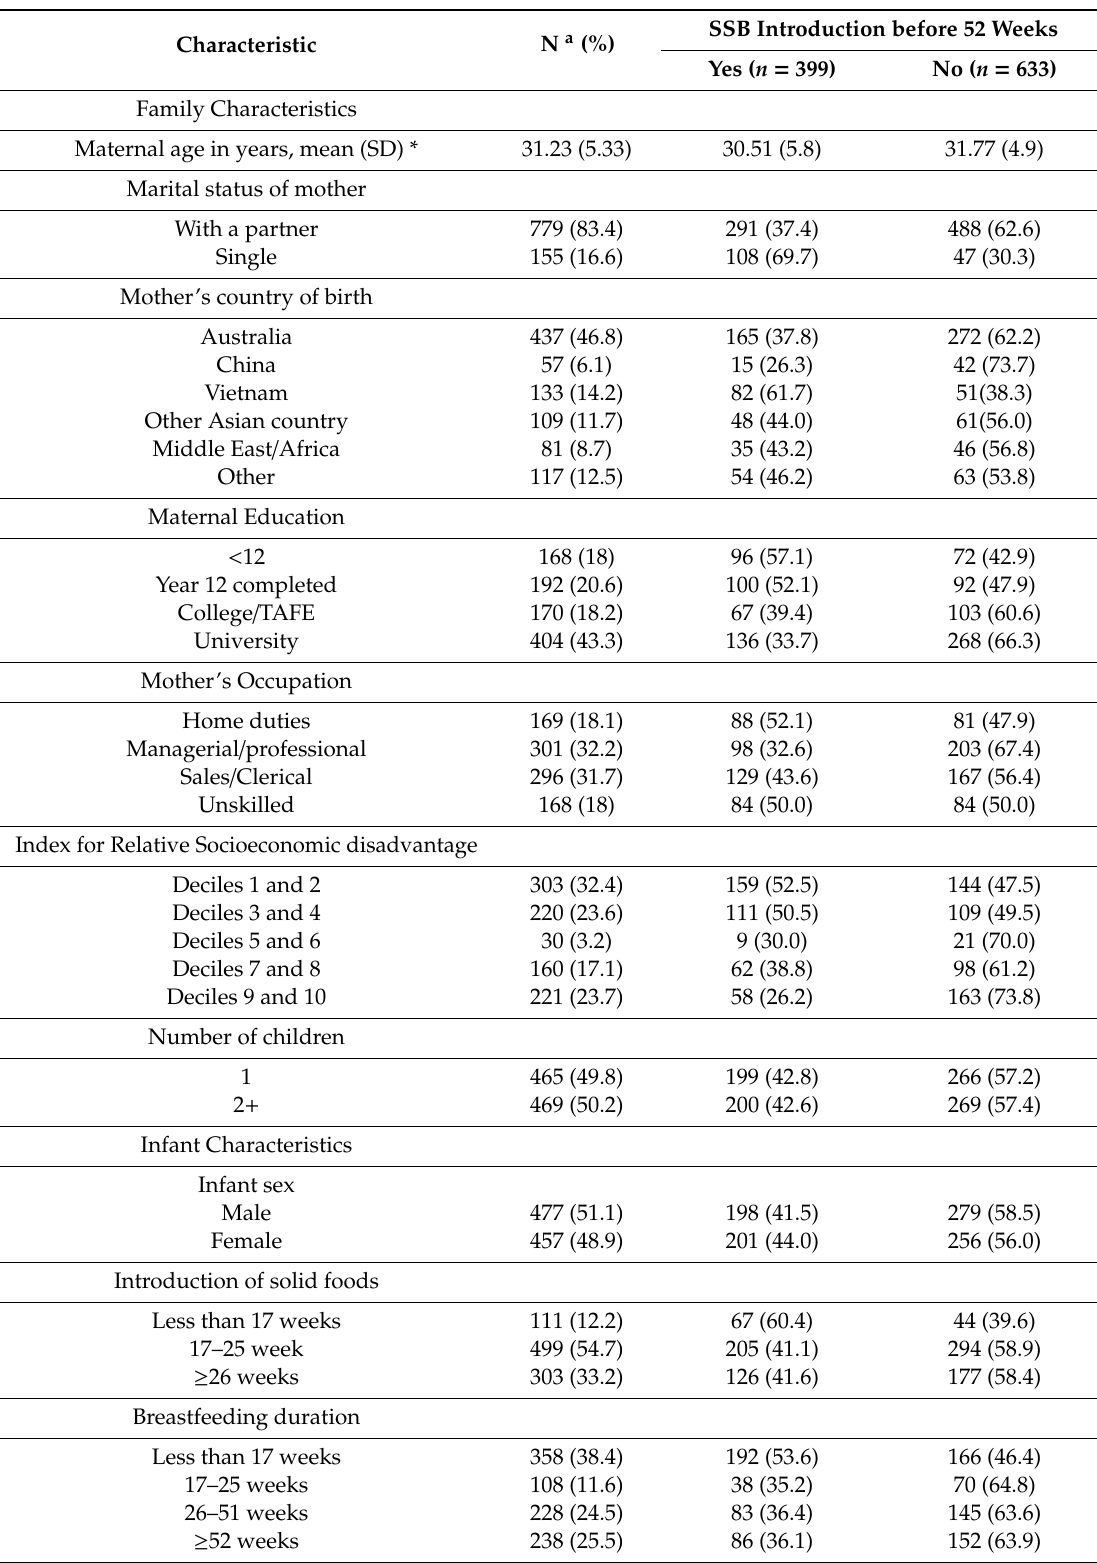
Table 1. Family and infant characteristics associated with early introduction of SSBs ( n =